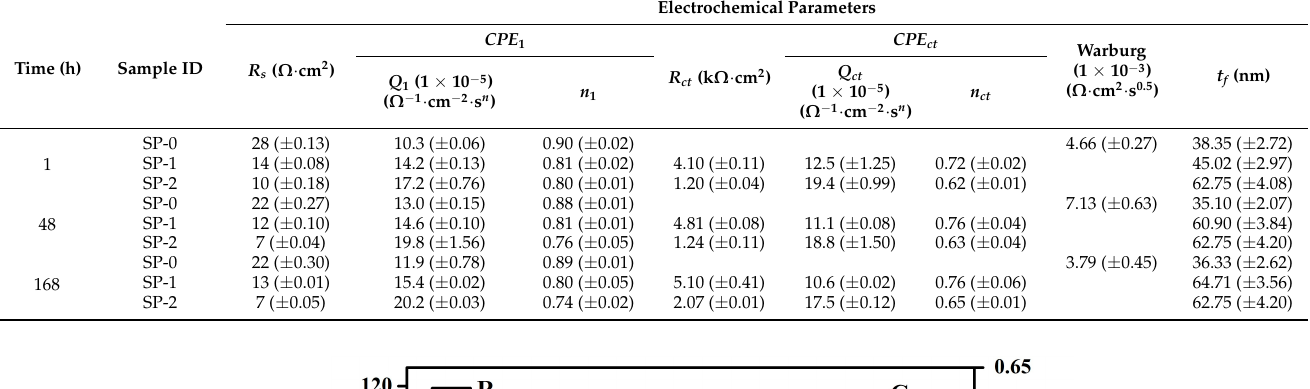
Table 3. Electrochemical parameters of steel rebar immersed in different solutions.